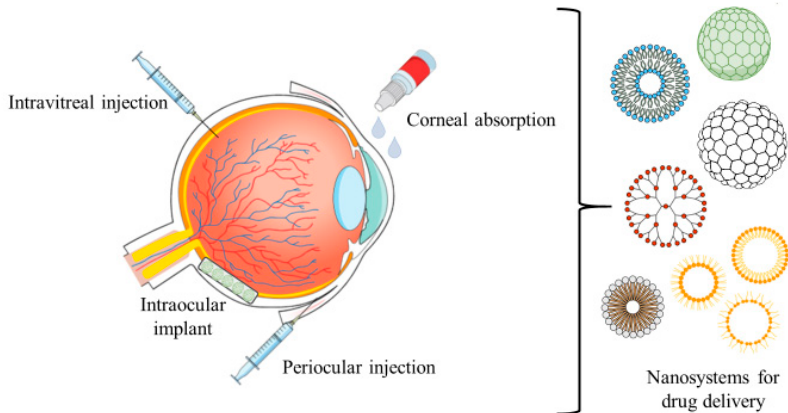
Figure 1. Ocular routes for drug delivery systems.